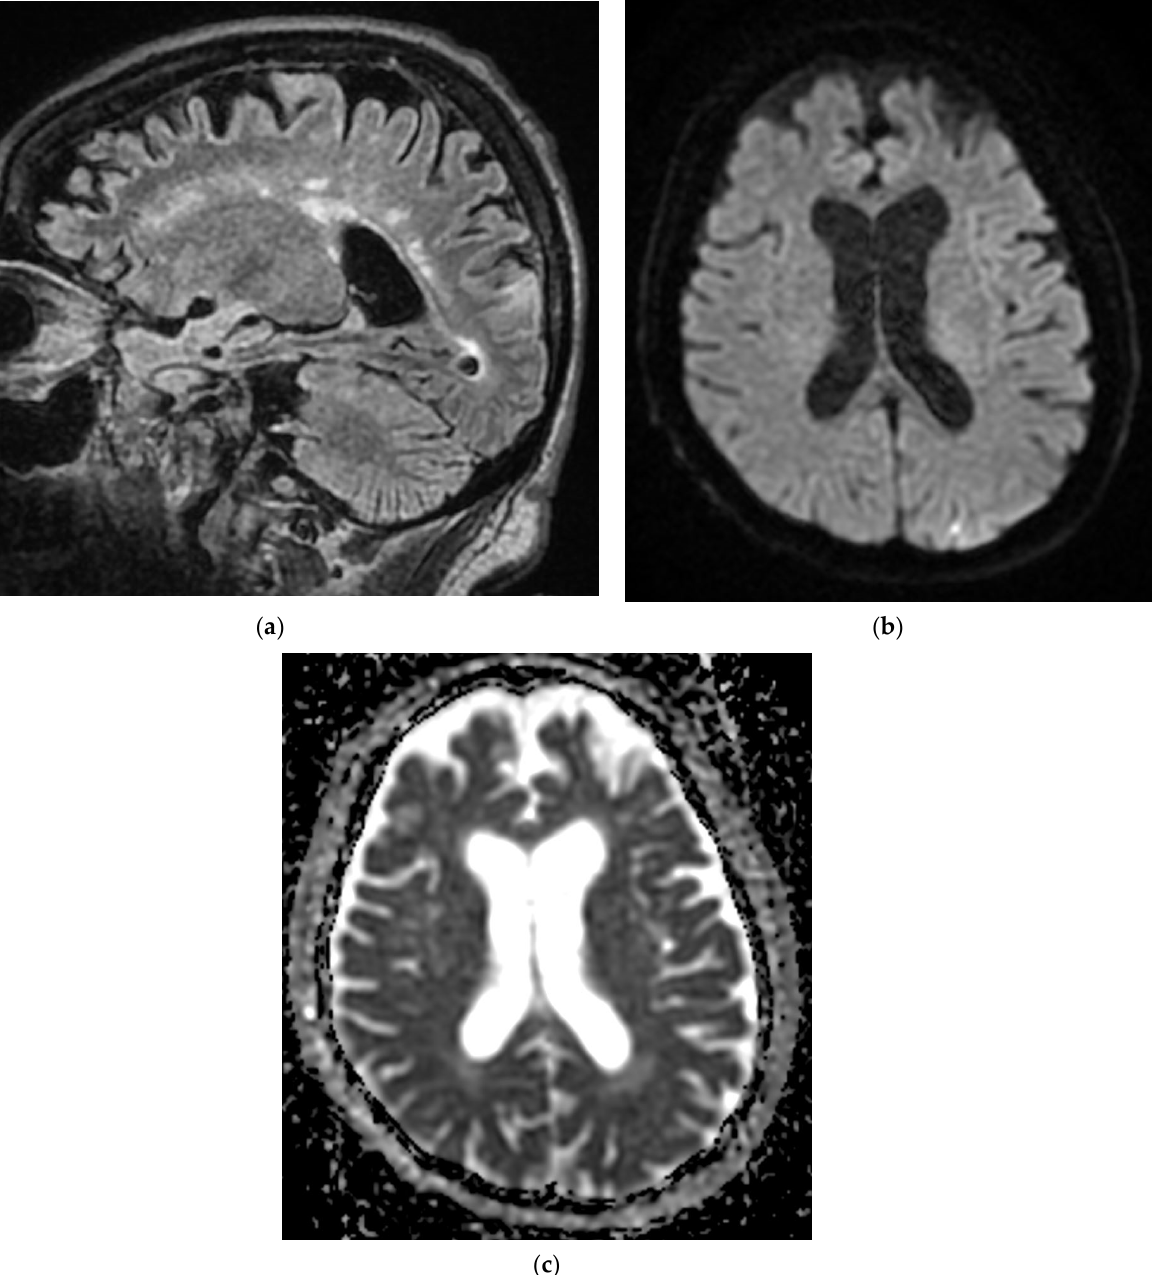
Figure 8. MRI sequences for the Case 8 patient indicate infra-centimetric foreshore of intense FLAIR signal ( a ), moderately restrictive in diffusion ( b , c ), situated on the left superior occipital lobe revealing subacute left superior occipital infarction.